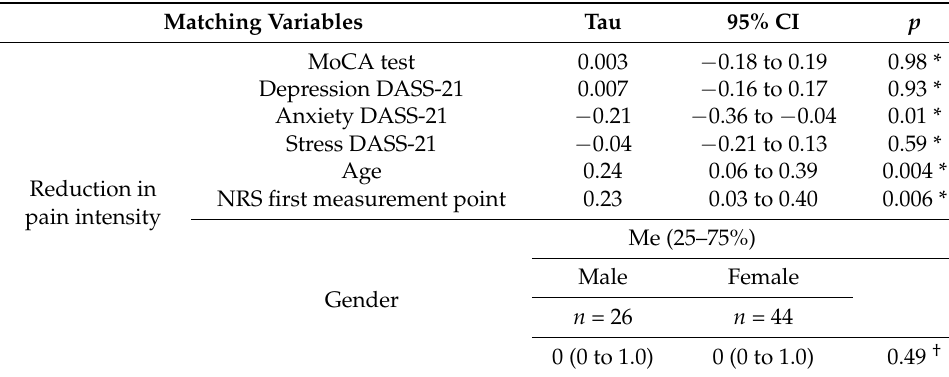
Table 4. Correlation between reduction in pain intensity and cognitive status, emotional status (depression, anxiety, and stress), age, gender, NRS at first visit, and NRS at control visit. Matching Variables Tau 95% CI p MoCA test 0.003 − 0.18 to 0.19 0.98 * Depression DASS-21 0.007 − 0.16 to 0.17 0.93 * Anxiety DASS-21 − 0.21 − 0.36 to − 0.04 0.01 * Stress DASS-21 − 0.04 − 0.21 to 0.13 0.59 * Age 0.24 0.06 to 0.39 Reduction in NRS first measurement point 0.23 pain intensity